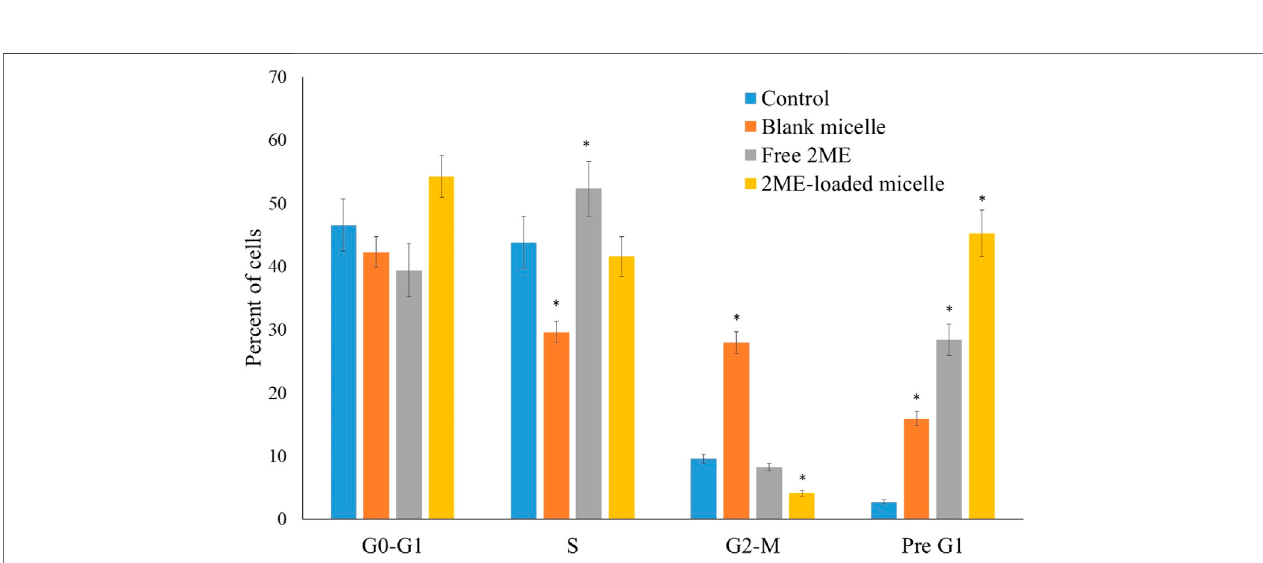
FIGURE 6 | Flow cytometric analysis of blank micelles, free-2ME, and 2 ME-loaded micelles on the cell cycle distribution of PC-3 cells. * represents signi fi cant difference from control group ( p < 0.05). Values are expressed as mean ± SD ( n (cid:2) 3).